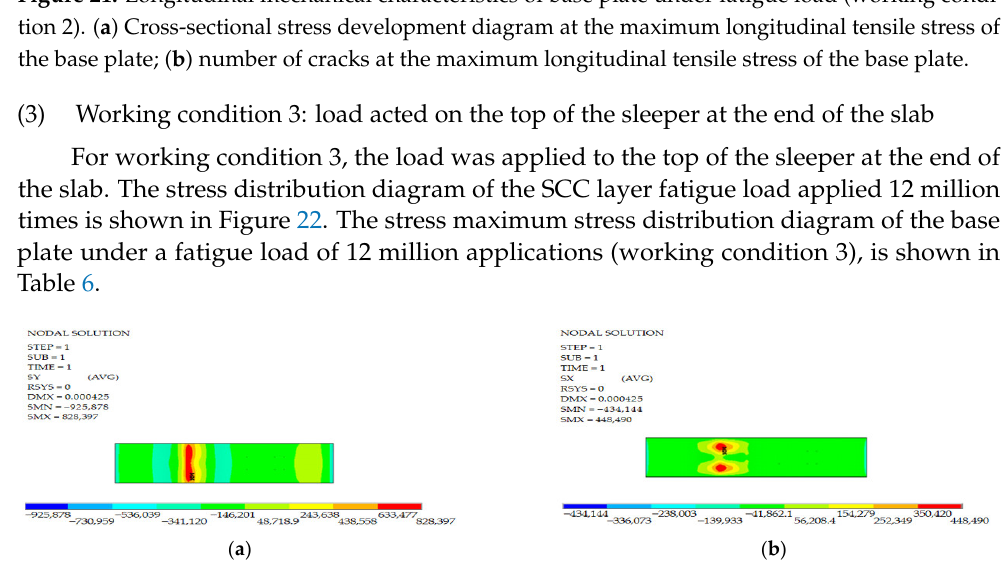
Figure 22. Stress distribution diagram of the base plate under fatigue load of 12 million applications (working condition 3). ( a ) Longitudinal stress of base plate; ( b ) lateral stress of base plate. Table 6. Maximum stress of the base under working condition 3.